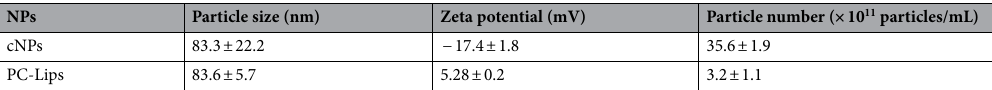
Table 1. Characteristics of cNPs or PC-Lips. Results are expressed as the mean ± standard deviation (SD) of three independent